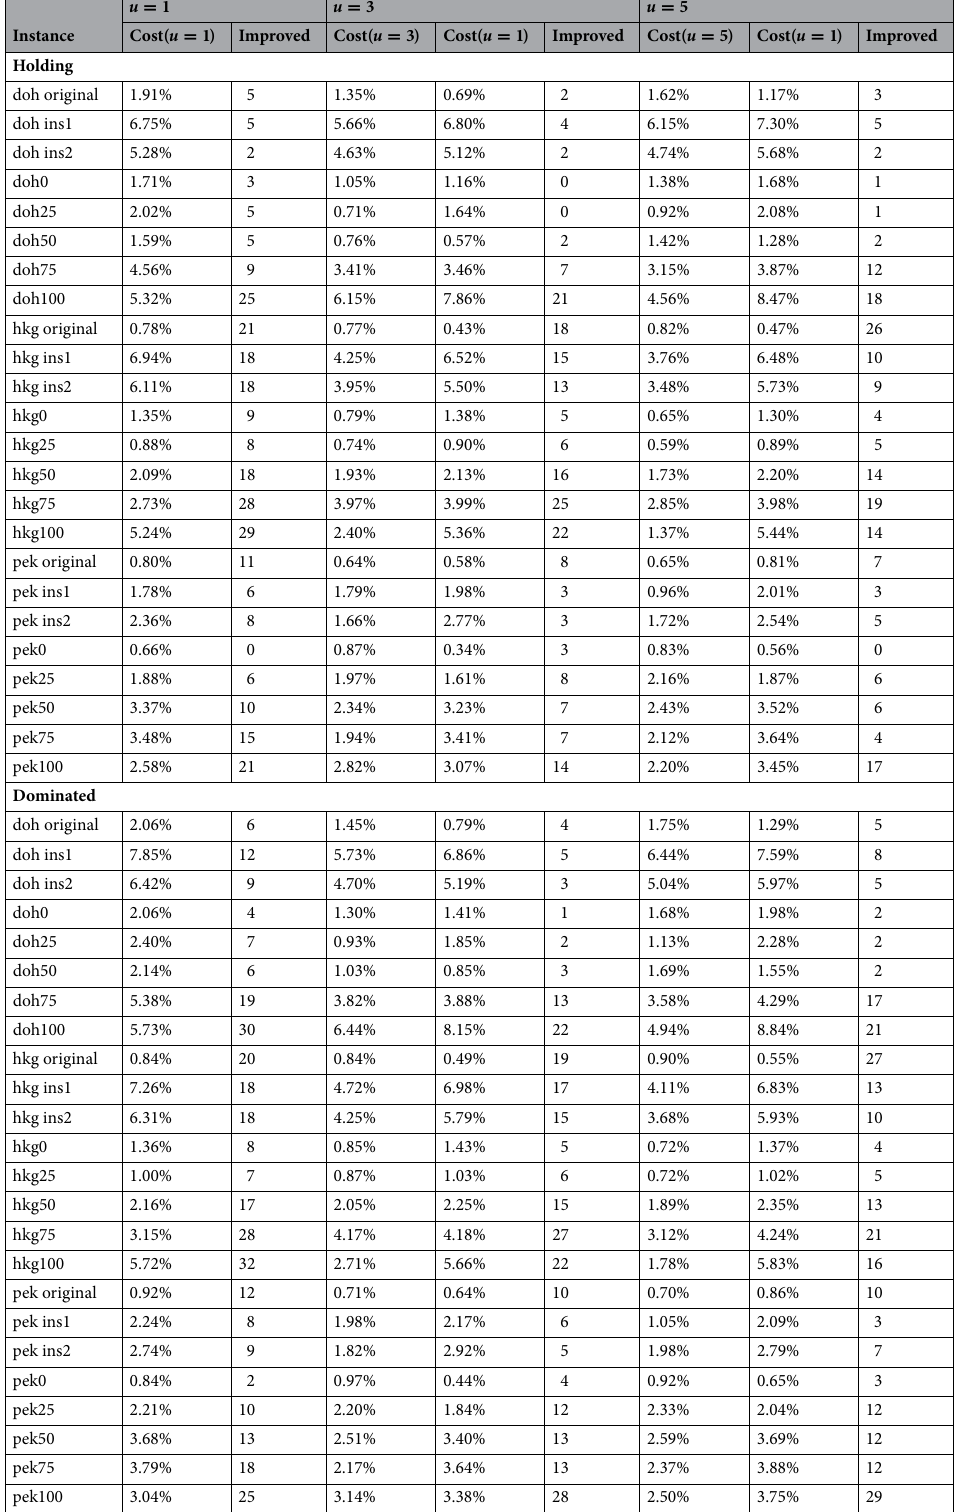
Table 5. Results for experiments with dominated speed